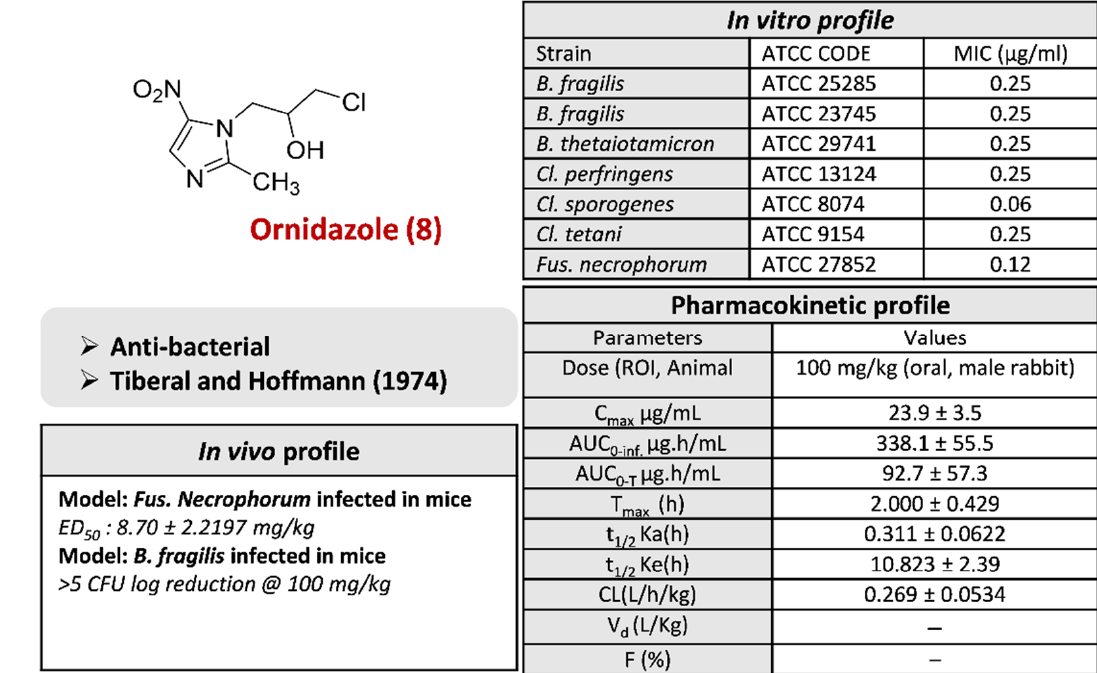
Figure 12. Activity profile of Ornidazole 8 [50,101,109–111,113]. Skupin et al. (1997) developed an enzymatic method to synthesize optically pure of Ornidazole 8 (Scheme 31, route A). In this method,